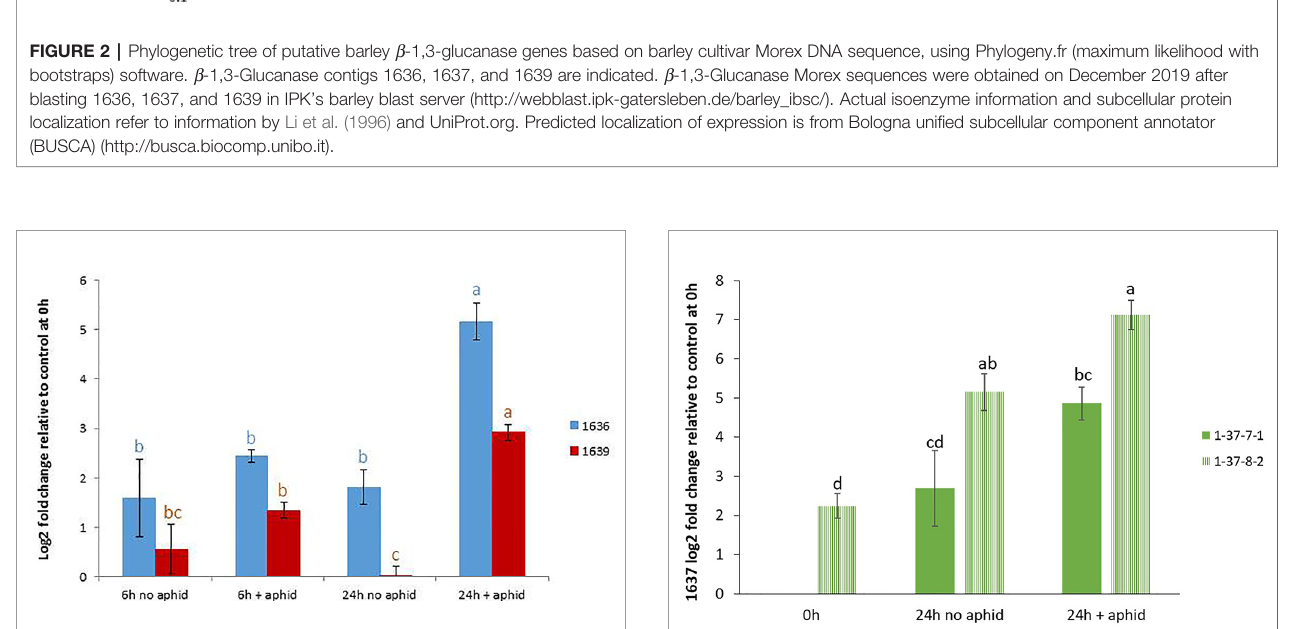
FIGURE 3 | Relative gene expression levels (mean ± SE, n=5) of 1636 and 1639 in Golden Promise, expressed as fold change relative to their expressions at the start of the experiment and normalized against the changes in expression level of the reference genes SF427 and Hsp70. The data were analyzed by one-way ANOVA (see Table S1 ), followed by Tukey ’ s multiple comparison test for each gene separately. Different letters above bars indicate signi fi cant differences at p =0.05.